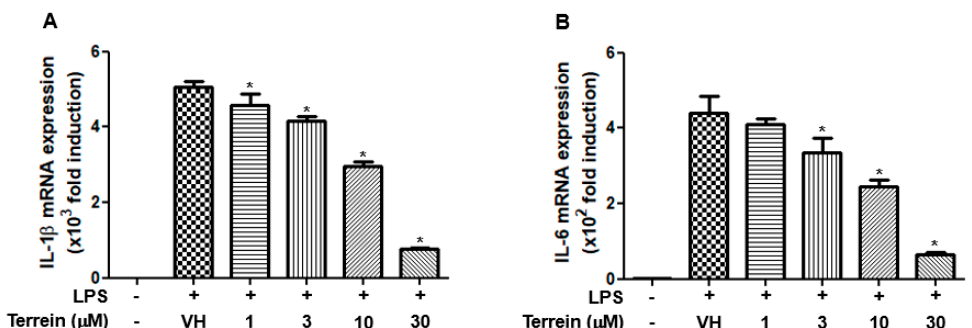
Figure 5. Effect of terrein on LPS − induced mRNA expression of inflammatory cytokines in RAW 264.7 cells. RAW 264.7 cells were pretreated with the indicated concentrations of terrein for 1 h before being incubated with LPS (200 ng/mL) for 6 h. The mRNA expression of IL − 1 β ( A ) and IL − 6 ( B ) was measured using quantitative RT − PCR. Each column shows the mean ± standard deviation of quadruplicate determinations. Significance was determined using Dunnett’s t − test versus vehicle − treated group (* p < 0.05).